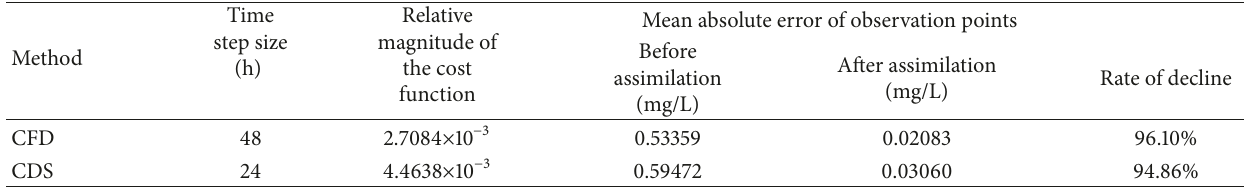
Table 6: The results of the adjoint model using CFD and